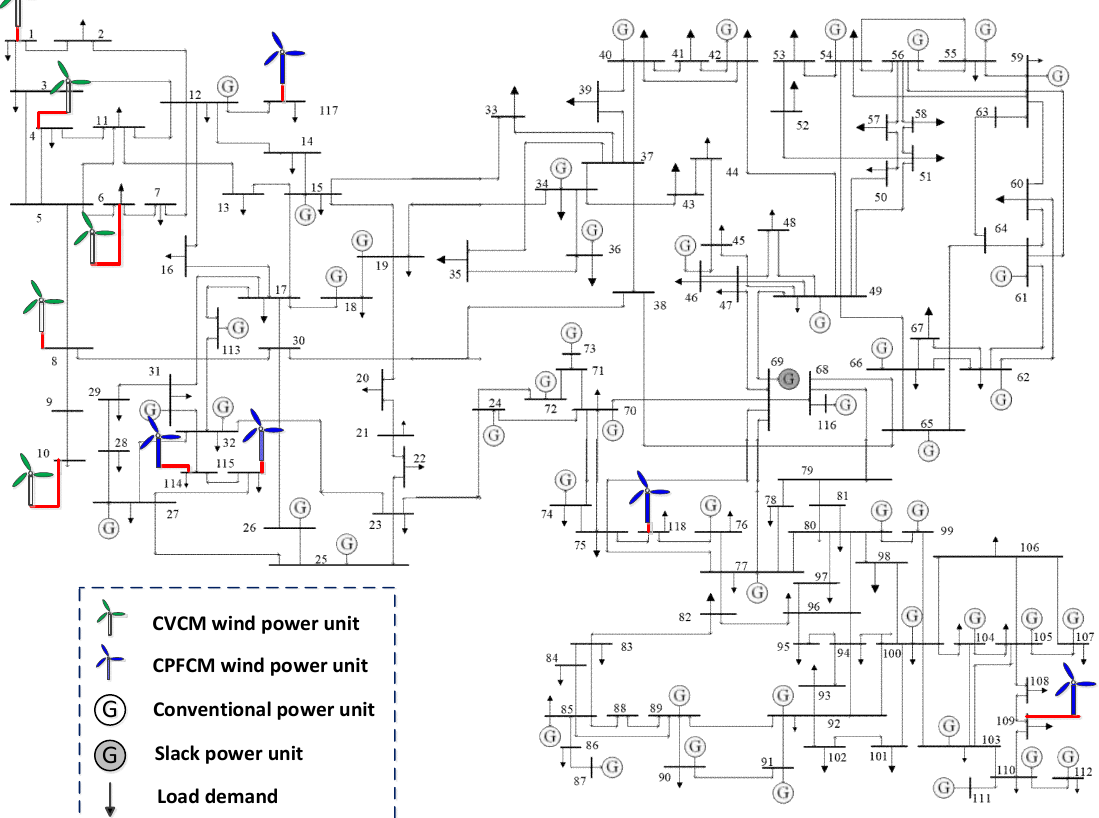
Figure 11. Layout of the IEEE 118 bus system with different wind power farms. Table 2. Parameters of wind speed and wind farms in the IEEE 118-bus